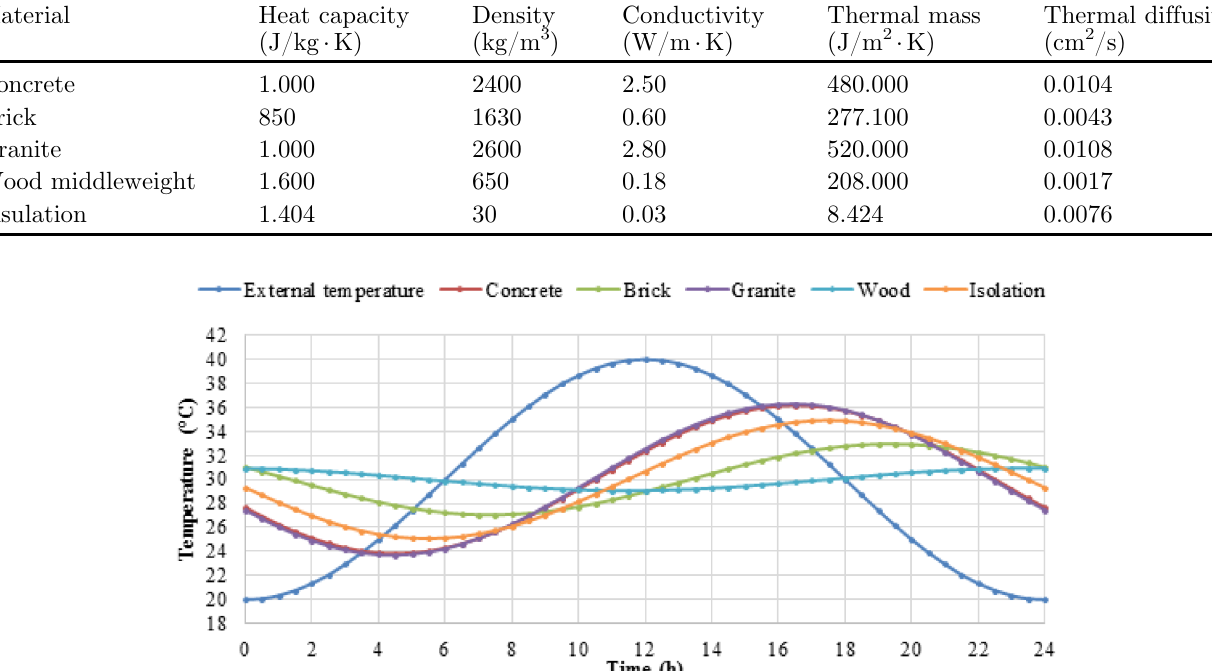
Table 1. Thermal properties of materials used in the simulation (IETCC, 2010). Material